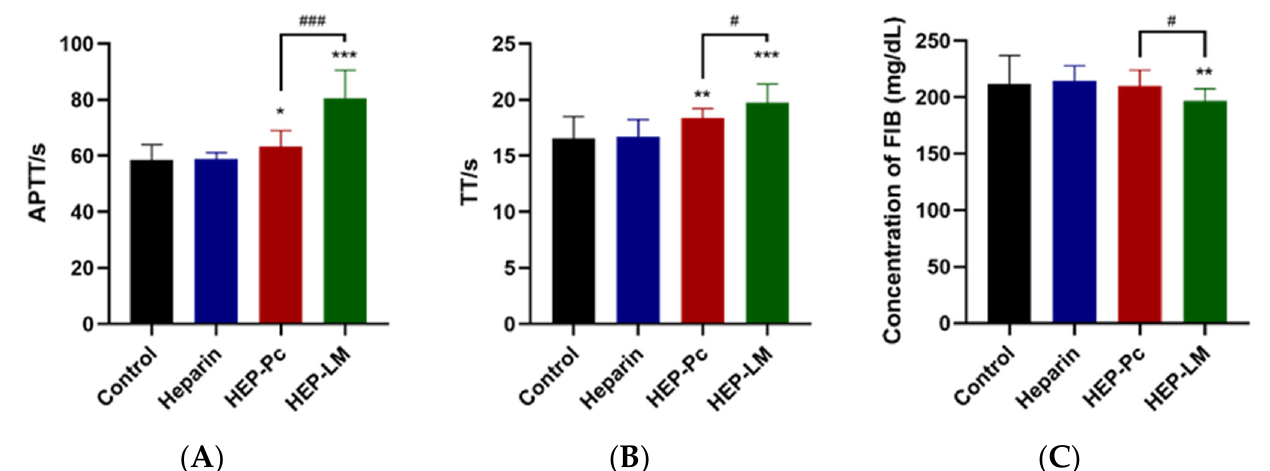
Figure 8. Anticoagulation of the HEP–Pc complex and HEP-LM oral administration in mice on ( A ) activated partial thromboplastin time (APTT), ( B ) thrombin time (TT), and ( C ) fibronectin (FIB). Values are expressed as the mean ± SD. * p < 0.05, ** p < 0.01, and *** p < 0.001 compared with oral heparin; # p < 0.05 and ### p < 0.001 compared with HEP–Pc complex.